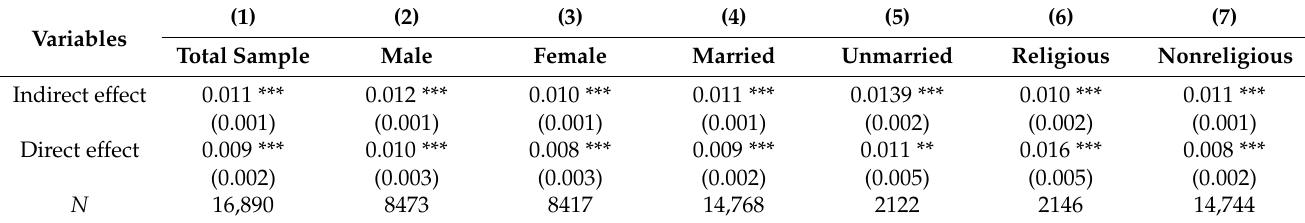
Table 8. Mediating effect of life satisfaction in impacts of work value perception on workers’ physical health. Variables